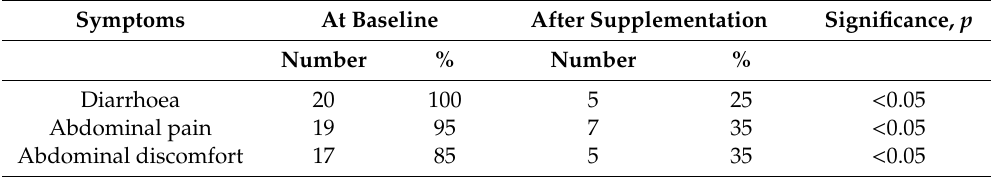
Table 3. Clinical improvement of patients with IBS after supplementation.